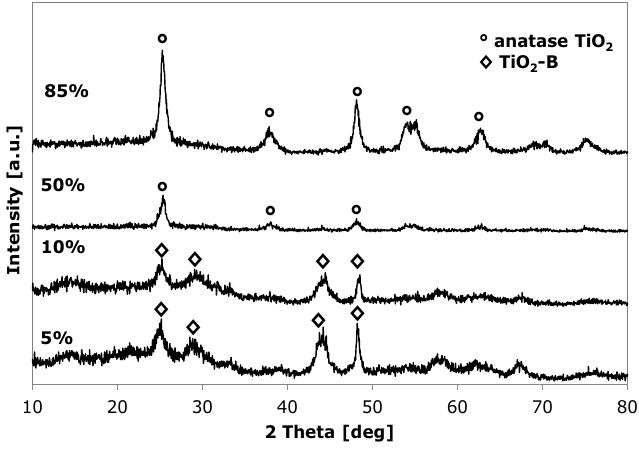
prepared in different NaOH concentrations. 2